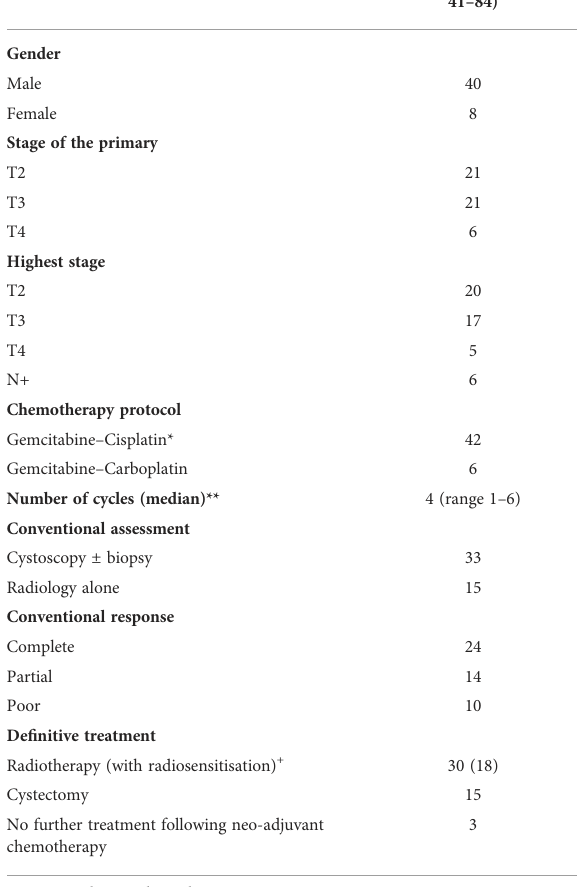
TABLE 1 Patient and tumour